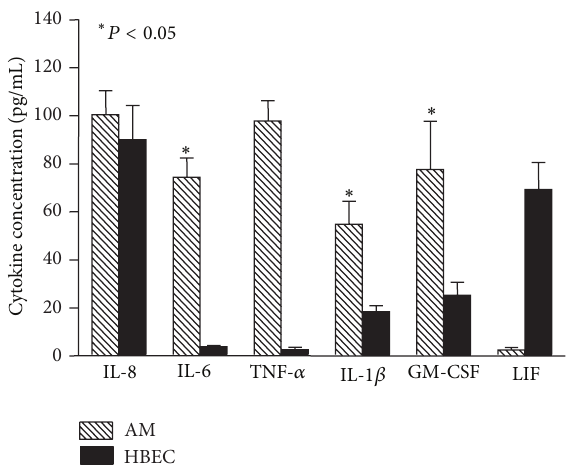
Figure 2: Cytokines produced by human AMs and bronchial epithelial cells (HBECs) when exposed to 100 𝜇 g/mL of PM 10 (EHC- 93) for 24 h. Alveolar macrophages produced significantly more IL- 6, IL-1 𝛽 , and GM-CSF than bronchial epithelial cells when exposed to same amount of PM 10